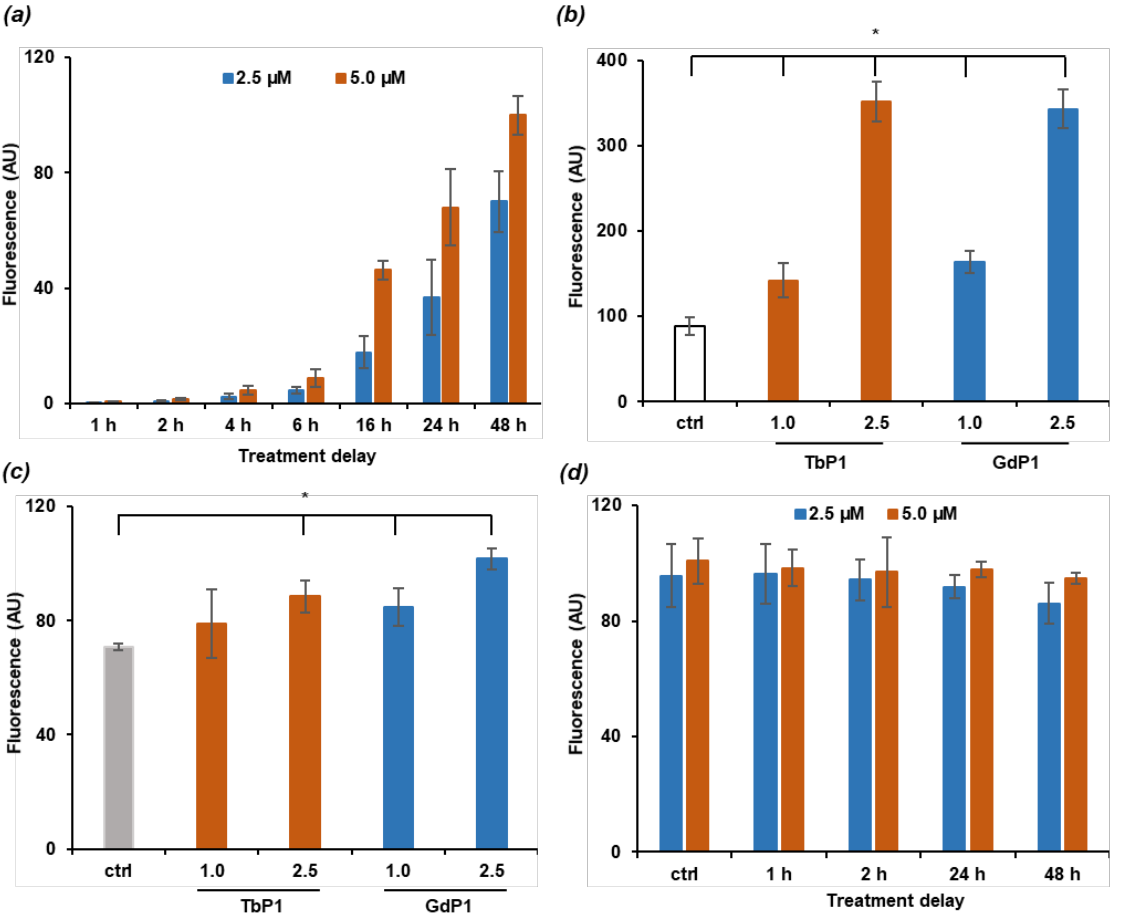
Figure 4. AGuIX@ complexes uptake by U-251 MG cells. ( a ) U-251 MG cell uptake kinetics with AGuIX@Tb-P1 were performed over 48 h. ( b ) Cell uptake between AGuIX@Tb-P1 (TbP1) and AGuIX@Gd-P1 (GdP1) was compared for 24 h, for P1 equivalent concentration of 1.0 and 2.5 µM. ( c ) Reactive species content was quantified using DCF2-DA fluorescent probe after cell exposure to 1 or 2.5 µM nanoparticles for 24 h. ( d ) AGuIX@Tb-P1 uptake-mediated cell death was estimated with propidium iodide dye after cell exposure to 2.5 and 5.0 µM AGuIX@Tb-P1 for 24 h. Results are means ± S.D. of triplicate determinations from three independent experiments. *, p < 0.05, relative to control cells (Kruskal-Wallis test and post-hoc by the Dunn’s test). Abbreviation: ctrl, untreated cells; AU, Arbitrary unit.